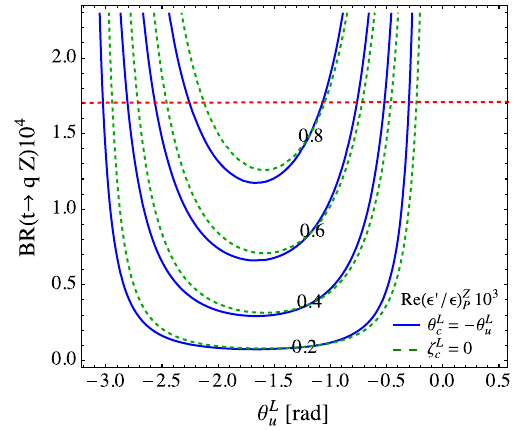
Fig. 2 Contours for Re ((cid:2) (cid:3) /(cid:2)) Z (in units of 10 − 3 ) as a function of P BR ( t → qZ ) and θ L u , where the solid and dashed lines denote the θ L = − θ L ζ L = 0 results, respectively. The BR ( t → qZ ) is c u and c defined as the minimal one between BR ( t → uZ ) and BR ( t → cZ ) . The horizontal dashed line (red) is the current upper limit of BR ( t